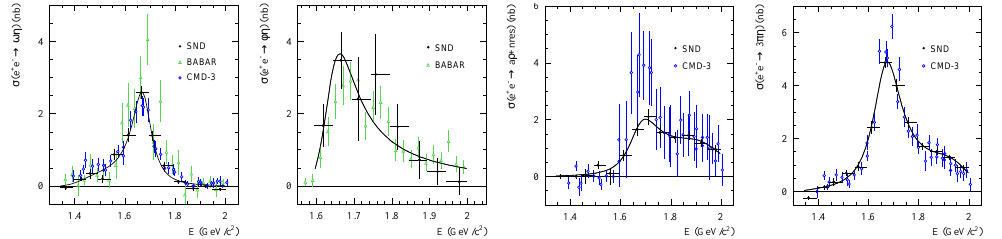
Figure 3. The cross sections for processes with intermediate states ωη , φη , a 0 ρ + nres and for the total process e + e − → π + π − π 0 η measured in this work (filled circles) and in the previous experiments [3, 6, 9] (open circles and triangles). Only statistical errors are drawn. The curves are the results of the fit described in the